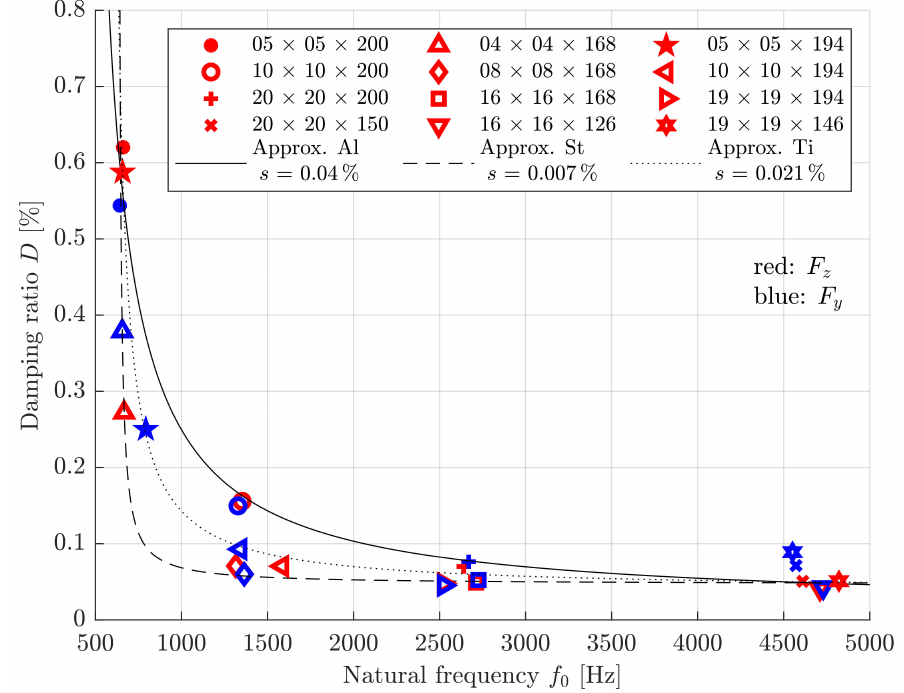
Figure 7. Frequency dependent damping of fully-fused (solid) beams, parameter 1, 12, 15, 18, 42, 45, 48, 51, 54, 57, 60,